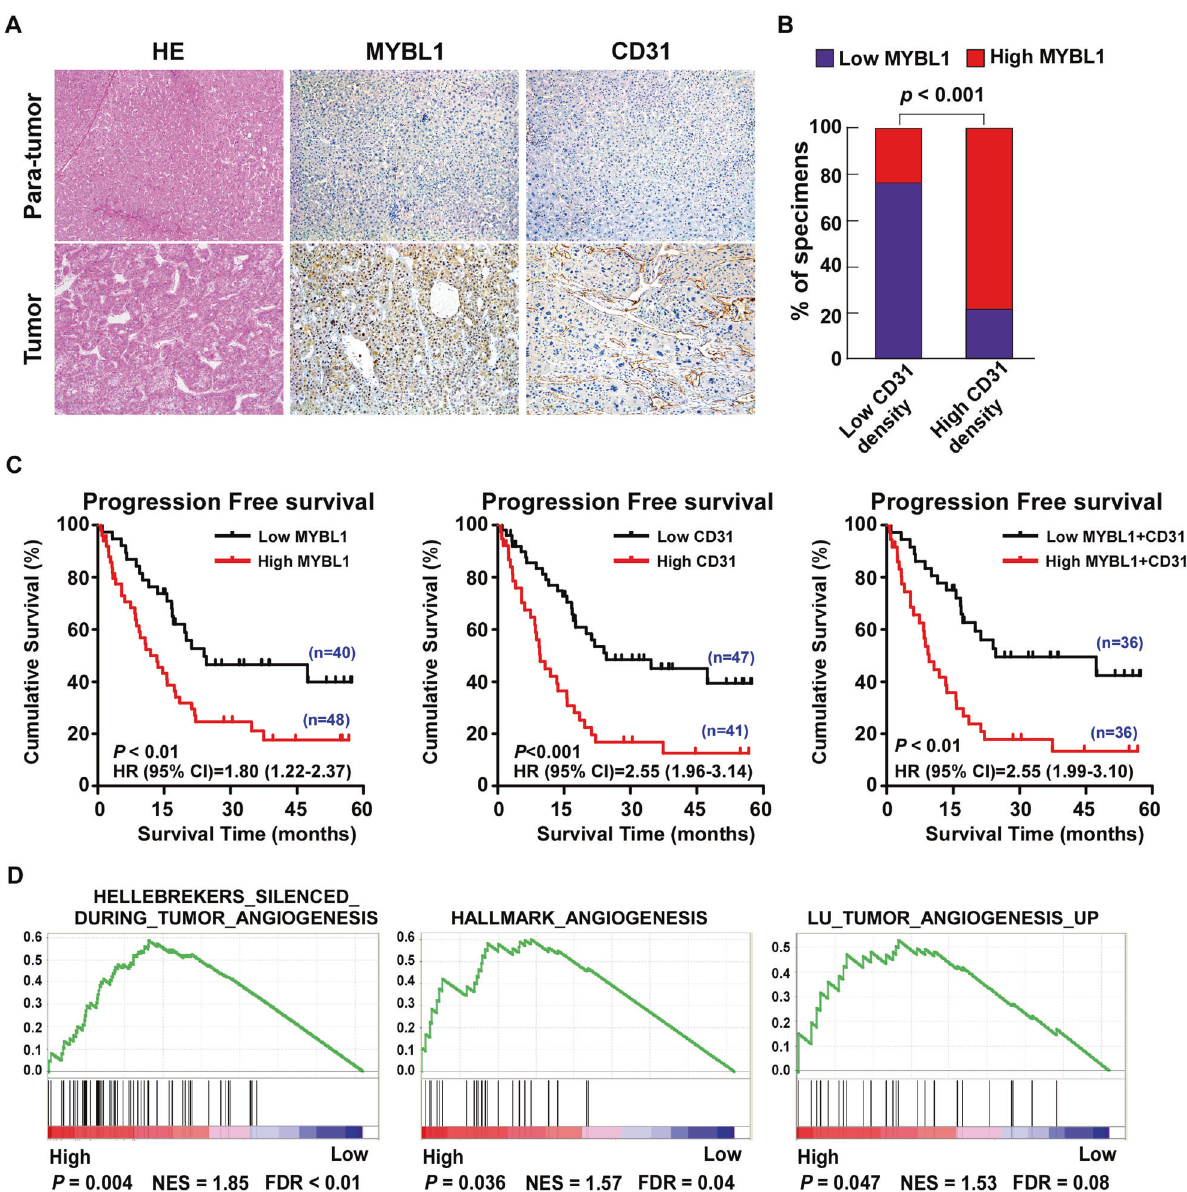
Fig. 1 Upregulation of MYBL1 correlates with high EV density and associates with HCC patient prognosis. A IHC staining indicating the MYBL1 and CD31 protein expression in para-tumor tissues and HCC tissues. B MYBL1 were positively correlated with CD31 protein levels in clinical specimens. C Patients with high MYBL1 expression (left), CD31 density (middle), and both MYBL1 and CD31 expression (right) show progression-free survival in HCC patients. D The correlation analysis between the mRNA levels of MYBL1 and angiogenesis in TCGA